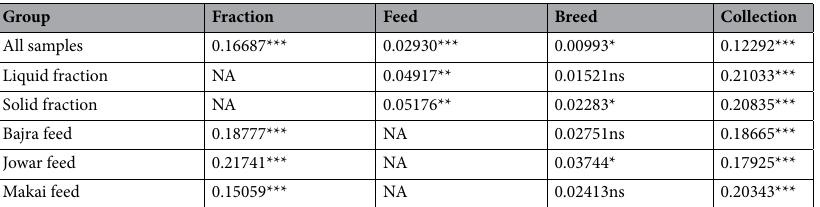
Table 1. Adonis (PERMANOVA) statistics applied on Bray–Curtis distance on relative abundance. Group column mentions the samples taken for respective calculations, while other columns are factors. Each value represents R 2 , p-value significance. NA Not applicable, ns not significant, ***< 0.001, **< 0.01, *< 0.05.